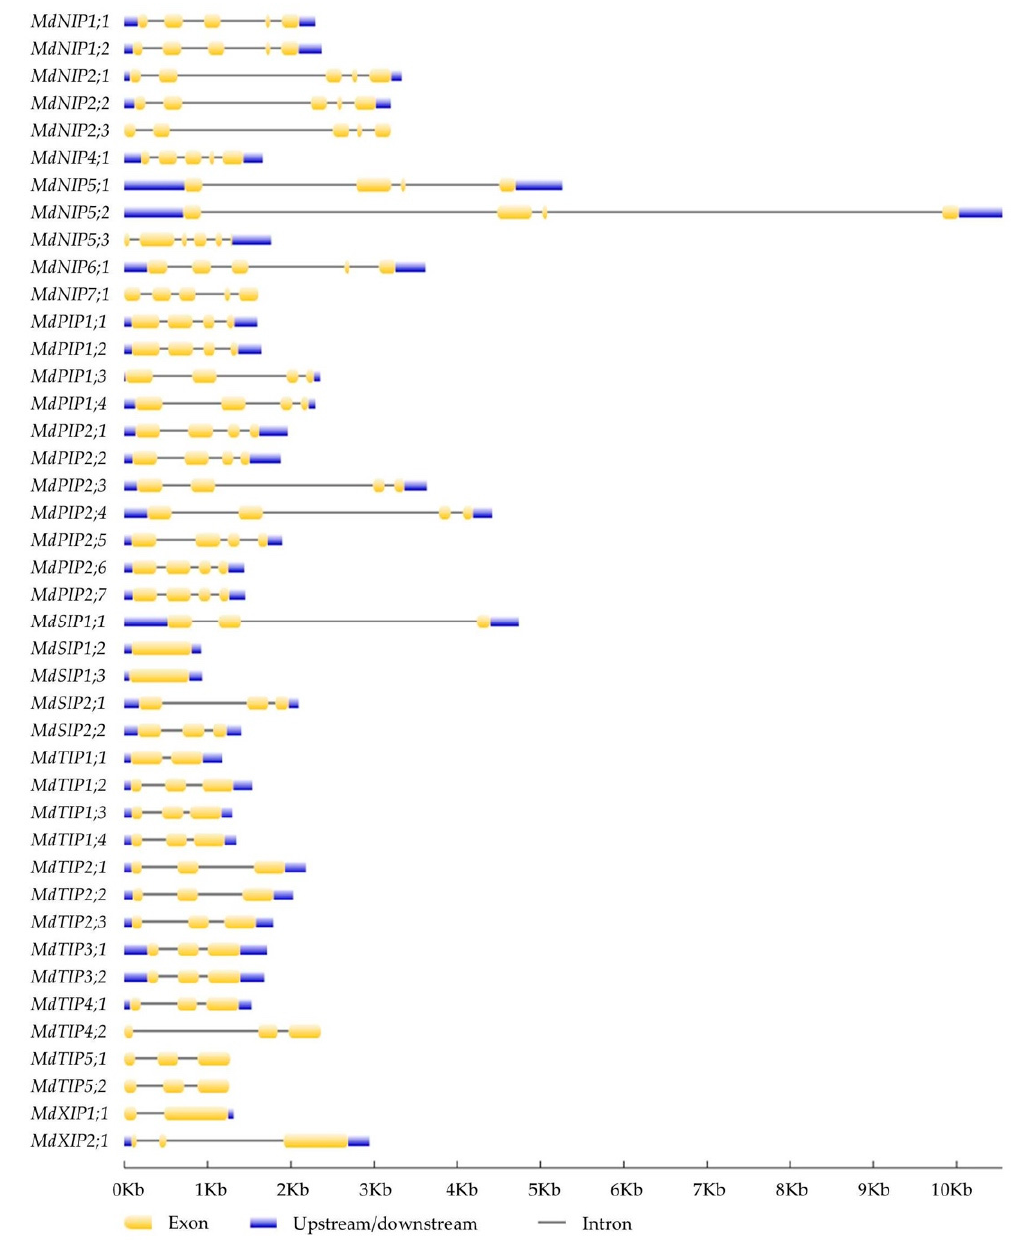
Figure 3. The exon-intron structure of apple AQP genes. Upstream / downstream region, exon, and intron are represented by blue box, yellow box, and grey line using GSDS software, respectively.